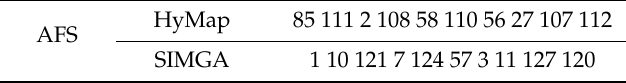
Figure 14. The first target and the HyMap dataset: ( a ) The optimal bands selected by AFS. The selected bands are represented by red vertical lines. ( b ) The last ten and the least discriminative bands selected by AFS. These features are represented by black vertical lines. ( c ) The target-background first-norm distances in the detection space with the last ten bands displayed by black spots. The first target and the SIM.GA dataset: ( d ), ( e ), and ( f ) are similar to ( a ), ( b ), and ( c ), respectively. In ( a , b ) and ( d , e ), the green curve with bigger width represents the target signature and the blue curves are the cluster mean spectra. Table 6. The last ten features selected by